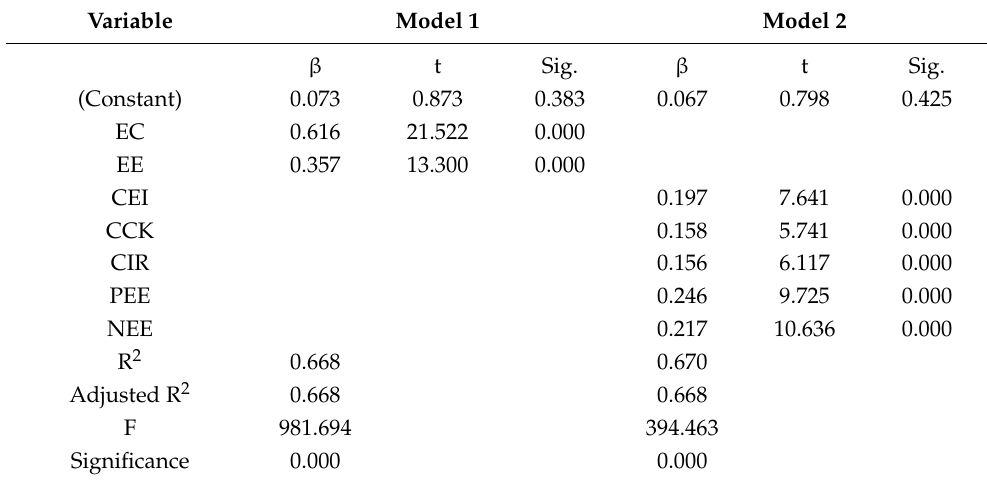
Table 7. Regression